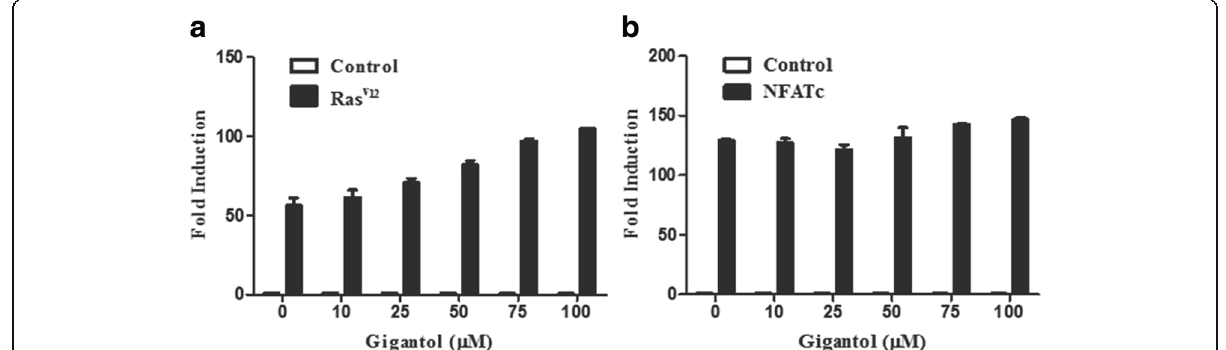
Fig. 2 Gigantol does not inhibit the luciferase activity of NFAT or the AP1 reporter gene. a A NFAT-Luc reporter along with a control vector or expression plasmid encoded NFATc were transfected into HEK293T cells. b An AP1-Luc reporter together with control vector or a constitutively active Ras v12 expression plasmid were transfected into HEK293T cells. Gigantol treatment and luciferase activity are presented in Fig.